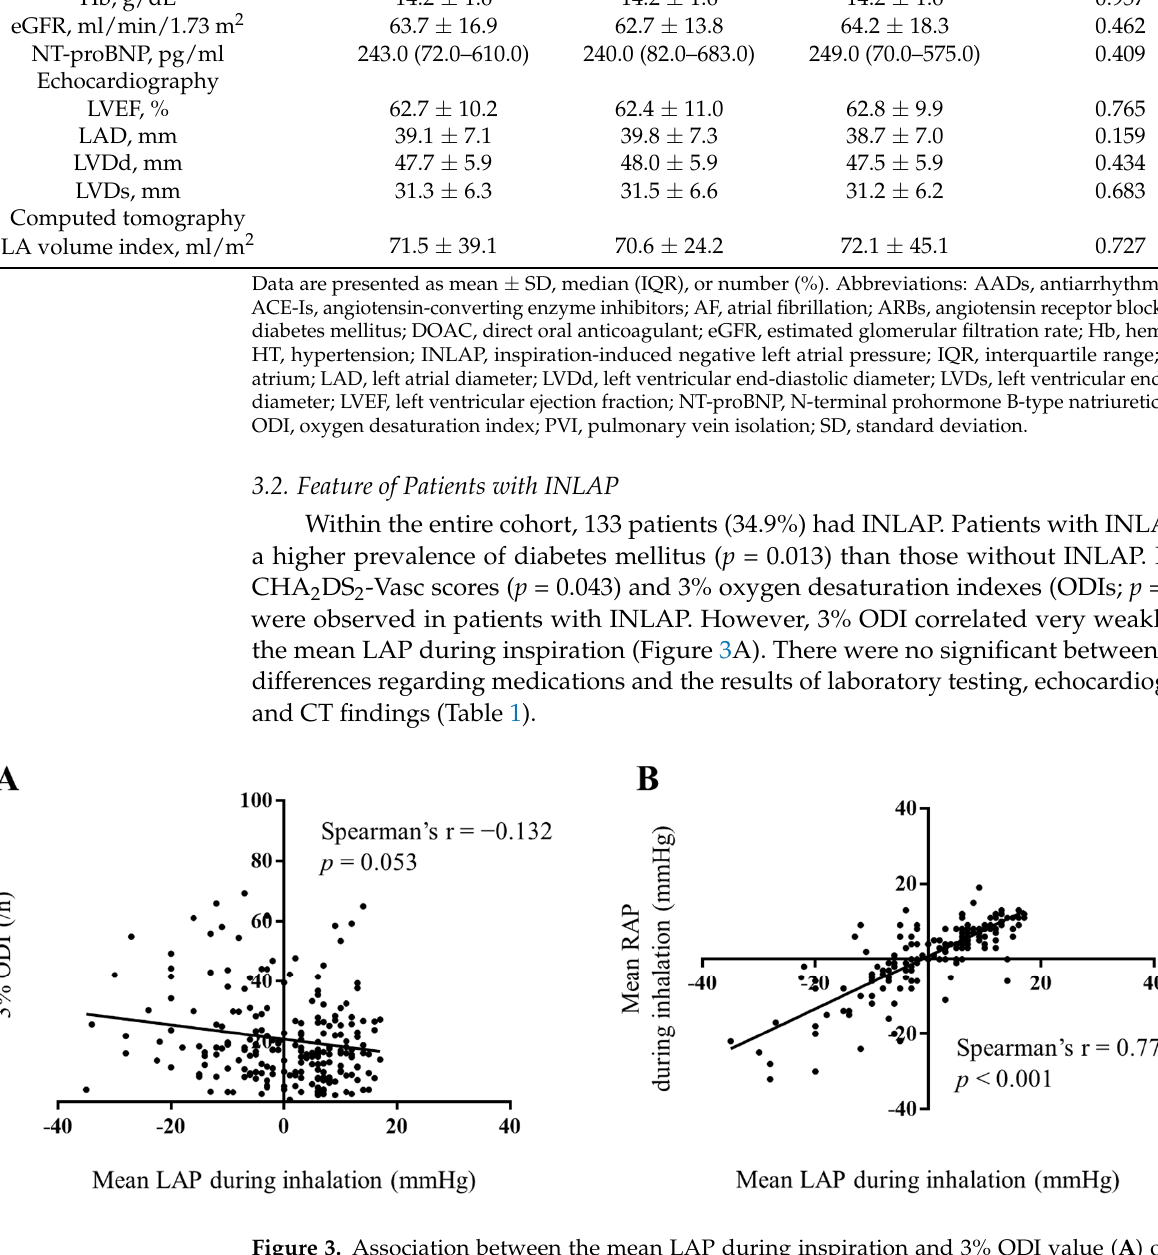
Figure 3. Association between the mean LAP during inspiration and 3% ODI value ( A ) or mean RAP during inspiration ( B ). The correlation is significant between mean LAP and mean RAP during inspiration (r = 0.775). Abbreviations: LAP, left atrial pressure; ODI, oxygen desaturation index; RAP, right atrial pressure.